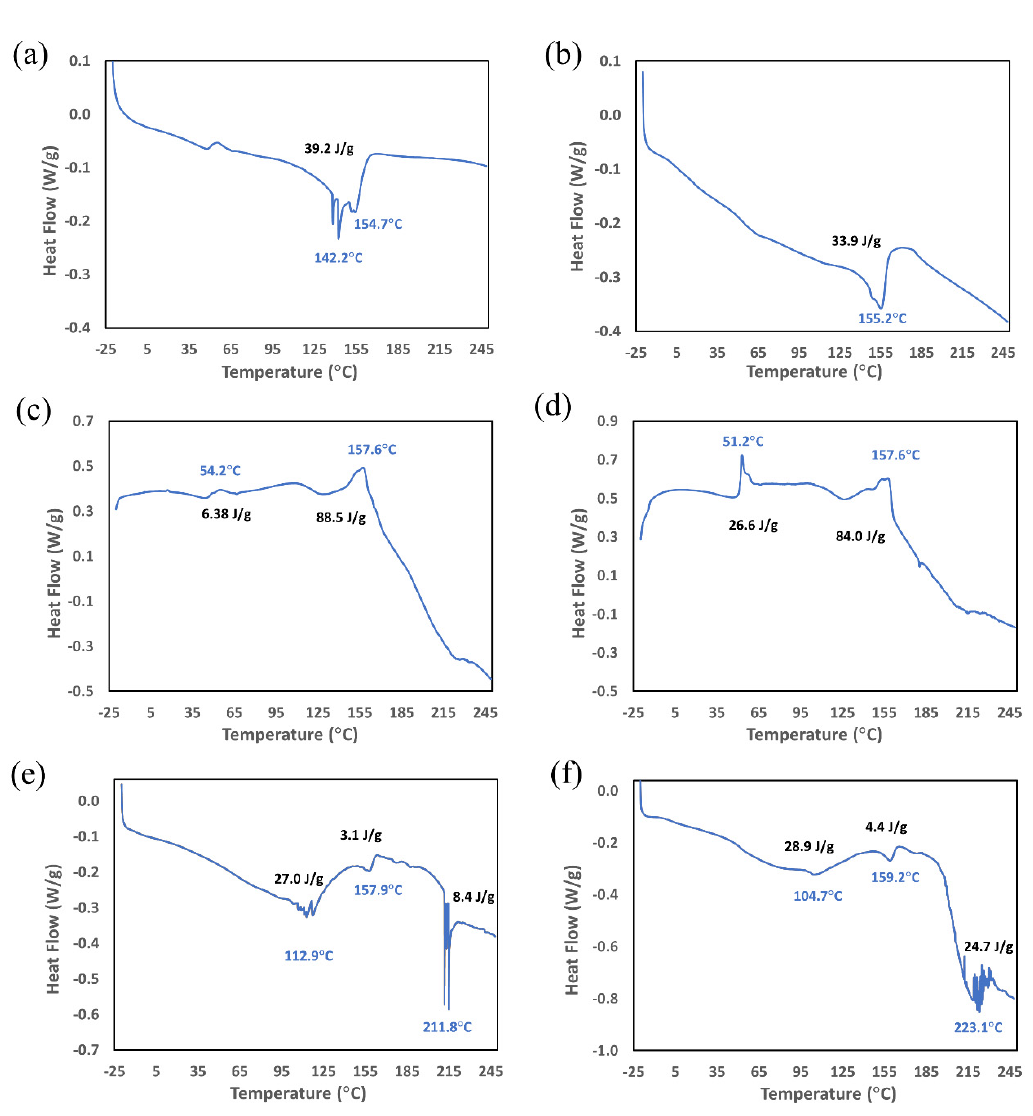
Figure 3. DSC thermogram of the solvent-cast samples prepared using HFP: ( a ) untreated PLGA, ( b ) plasma-treated PLGA, ( c ) untreated collagen, ( d ) plasma-treated collagen, ( e ) untreated PLGA- collagen, and ( f ) plasma-treated PLGA-collagen. Table 2. Thermodynamic parameters for the DSC heating ramp (endothermic